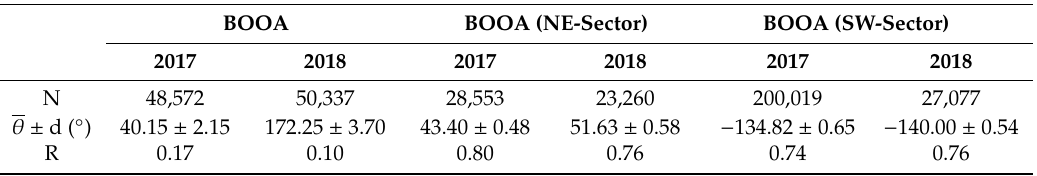
Table 2. Statistical distribution of wind parameters. BOOA represent winds from all directions. BOOA NE sector and BOOA SW sector represent the winds from 45 ◦ ± 90 ◦ and − 135 ◦ ± 90 ◦ directions, respectively. N is the number of observations. θ is the average wind direction. d represents the range for 95% confidence limits. R is the mean resultant vector length. BOOA BOOA (NE-Sector) BOOA